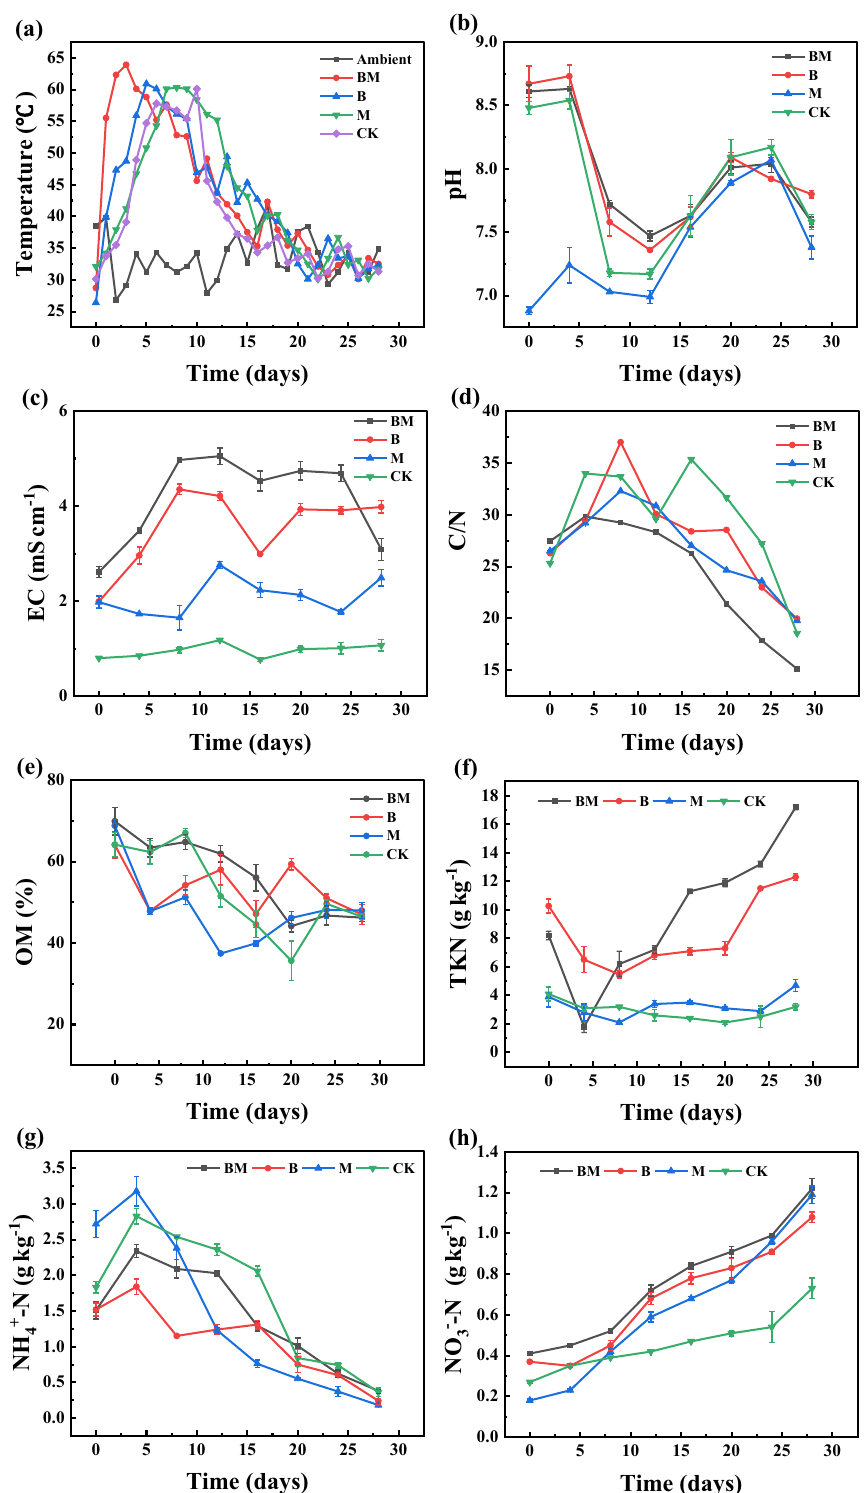
Fig. 3 Changes in temperature ( a ), pH ( b ), EC ( c ), C/N ( d ), OM ( e ), TKN ( f ), NH 4 + -N ( g ) and NO 3 − -N ( h ) in different treatments during composting. CK: sheep manure corn straw; M: CK 0.01% compound microbial agents; B: CK + + compound microbial agent to 0.1% biochar before being naturally dried). Results are the mean of three replicates and error bars indicate